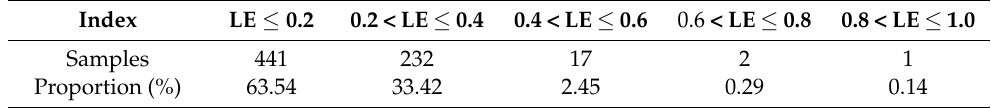
Table 3. The distribution of land-use efficiency.